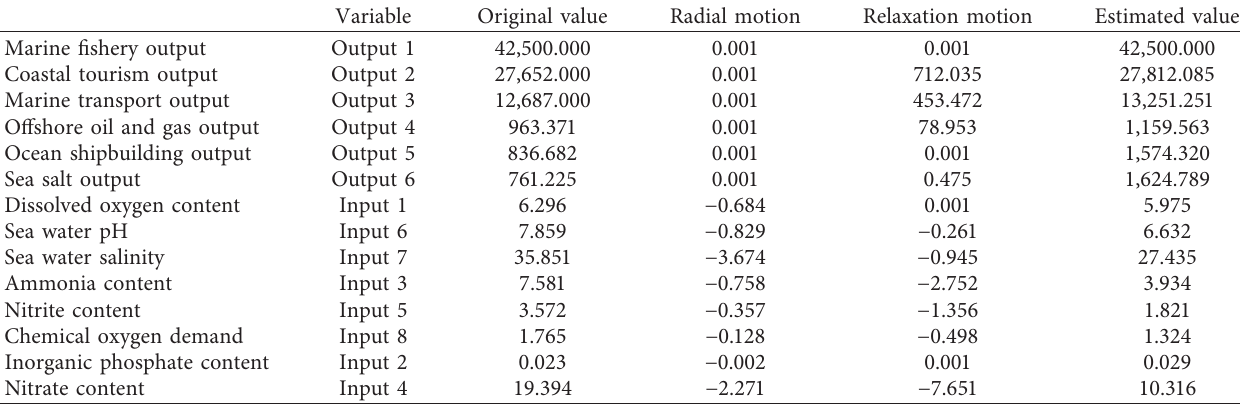
Table 1: Outputs of DUs.